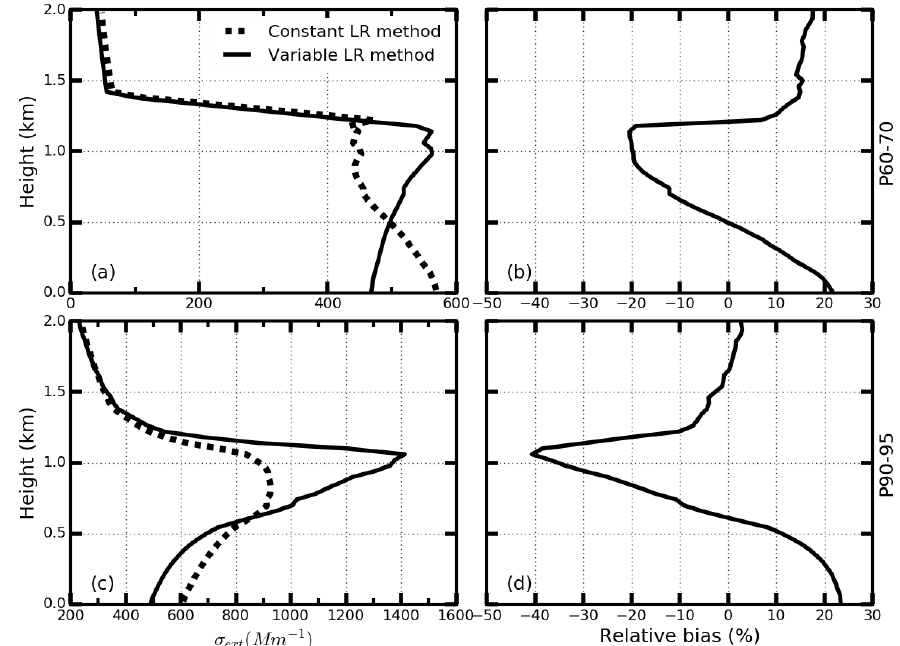
Figure 4. (a) Retrieved σ aero profiles using the constant LR profile method (dashed line) and the variable LR profile method (solid line) from simulated lidar signals. (b) The relative bias of the retrieved σ aero profile using two different methods. (c) and (d) are the same as (a) , (b) respectively. The LR signals of panel (a) results from the P70-80 RH profile and LR signals of panel (b) results from the P90-95 RH